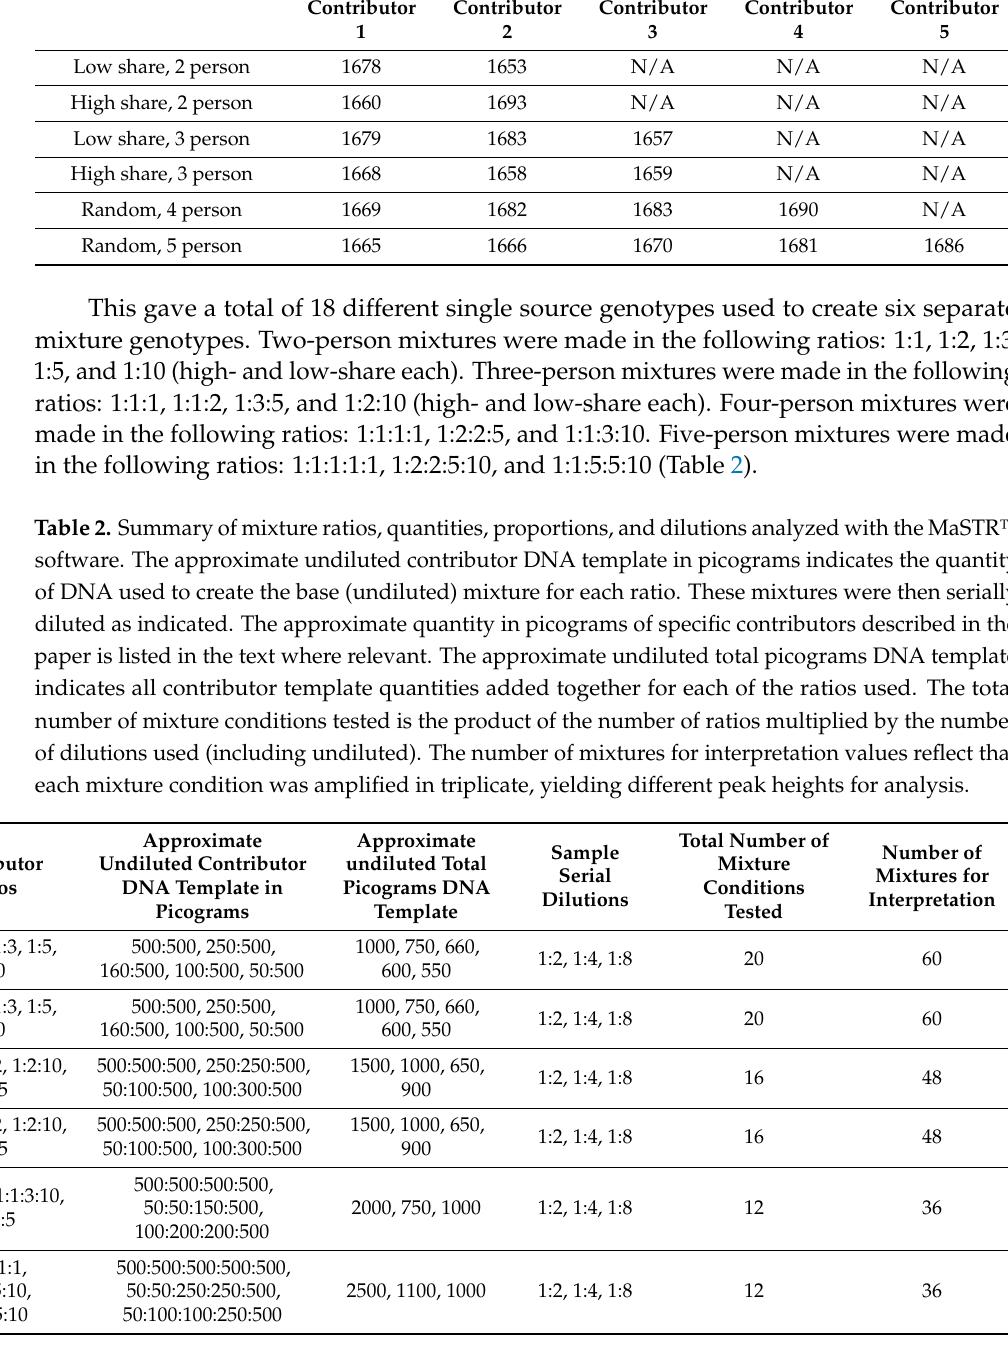
Table 1. Overview of the combinations of single source contributors in each mixture type. Type of Mixture